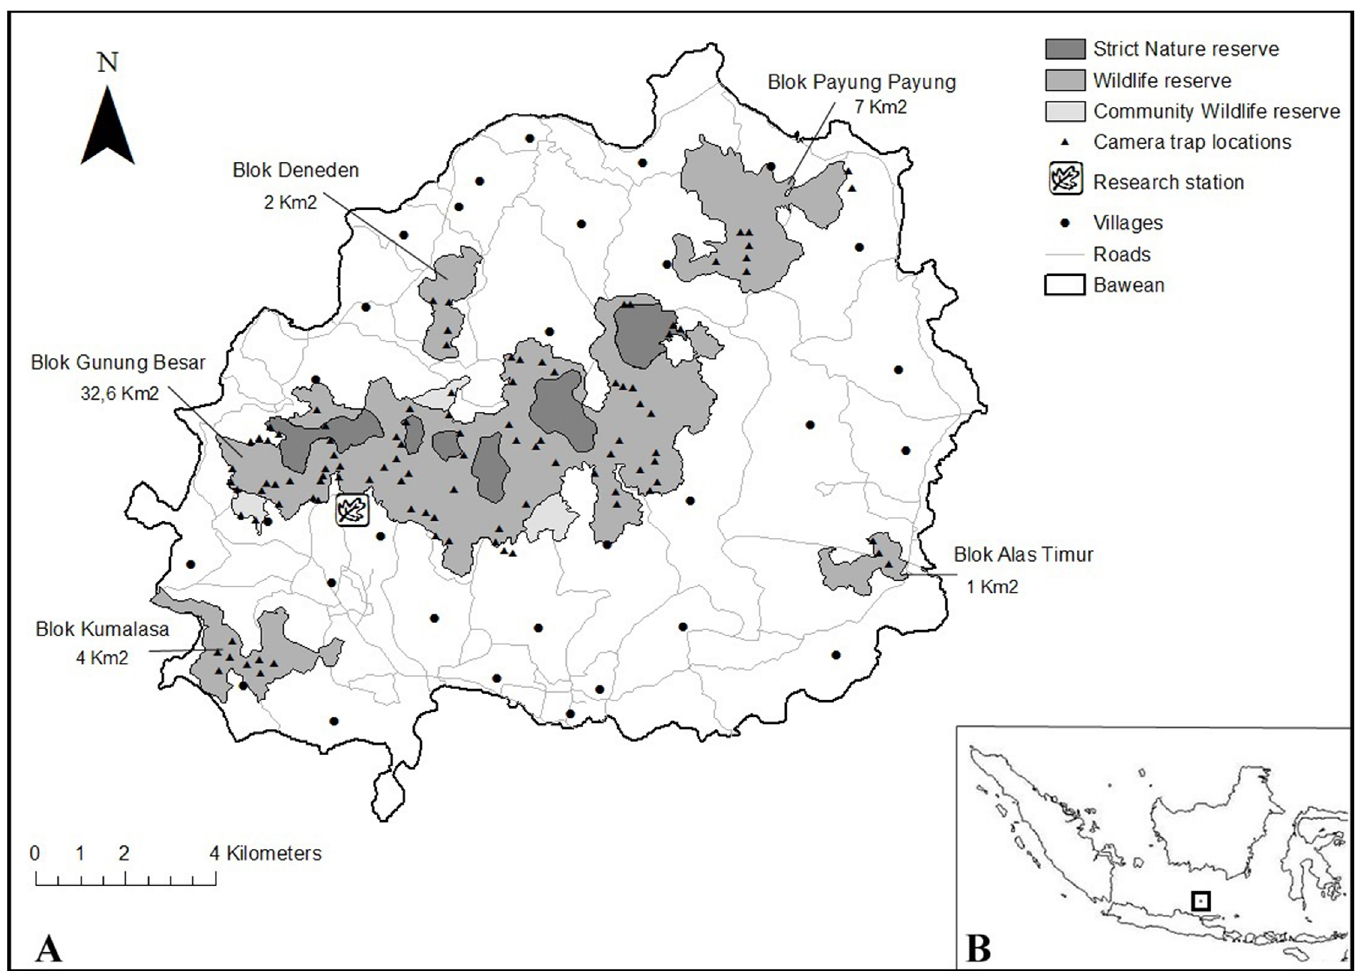
Fig 1. ( A ) Zonation of protected areas on Bawean Island, camera trap locations and the location of the research station. ( B) Location of Bawean in the Java Sea. A buffer of 100 meter from the outer forest edge was included into the ArcGIS base map due to the uncertainty of the official zonation (see text).